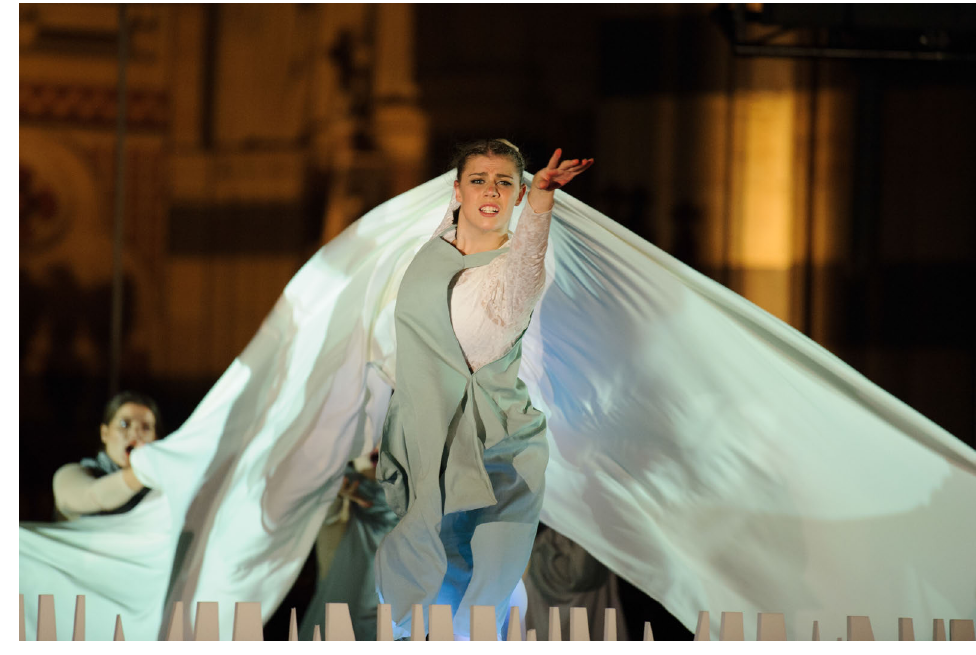
FFigigururee 1010.. Mary, played by Jordan Auld, searching for Jesus at the tomb. (Photo: Sarah Walker)